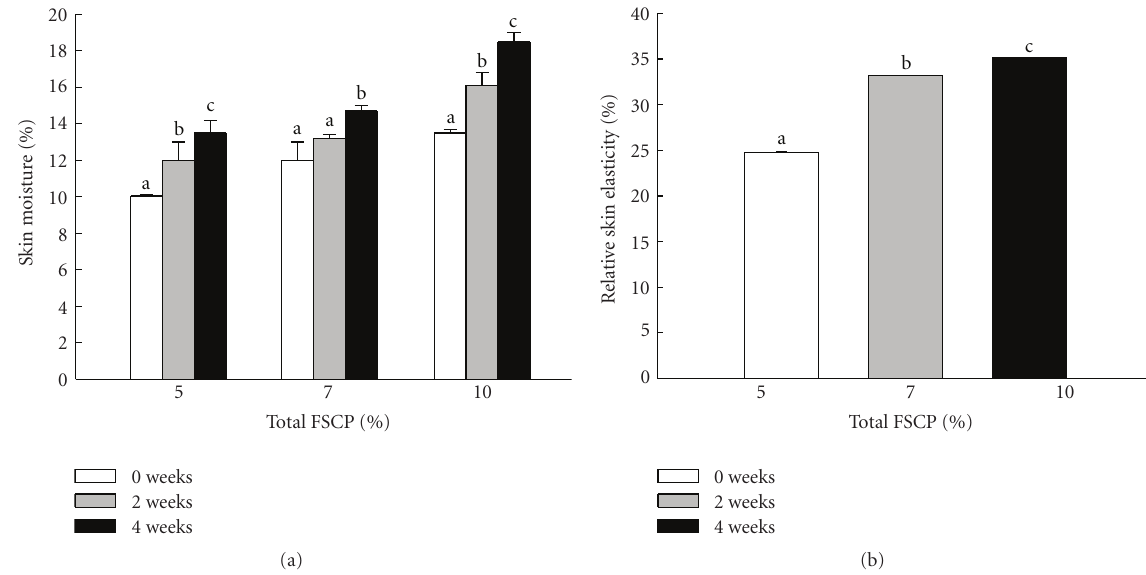
Figure 1: E ff ects of FSCP-based skin essence on moisture contents and relative elasticity of facial skins. The skin moisture contents (a) and relative skin elasticity (b) were measured by the professional skin measurement probes. Bars are expressed as means ± SEM in each group for the 62 subjects. Di ff erence letters in the same group indicate significant di ff erence ( P ≤ . 05).